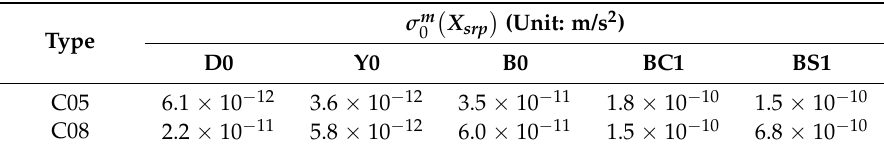
Table 10. A posteriori STD of the SRP parameters of the filter before the orbit maneuver. Type